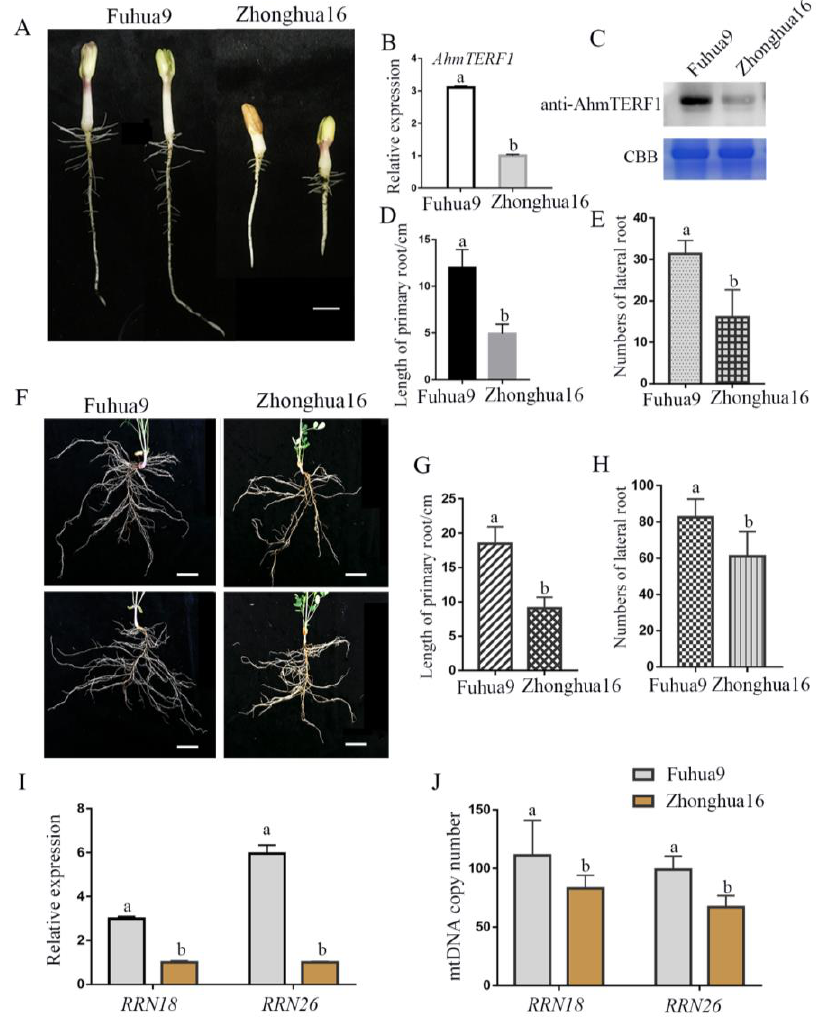
Figure 8. The effect of AhmTERF1 expression on root growth and mtDNA copy number in Fuhua9 and Zhonghua16 peanut cultivars. ( A ): Phenotype of 5 d-old Fuhua9 and Zhonghua16 cultivars. ( B , C ): AhmTERF1 transcript and protein expression, respectively, in the roots of 5 d-old Fuhua9 and Zhonghua16. ( D , E ): Length of primary root and number of lateral roots of 5 d-old Fuhua9 and Zhonghua16. ( F ): Phenotype of 25 d-old Fuhua9 and Zhonghua16 cultivars. ( G , H ): Length of primary root and number of lateral roots, respectively, of 25 d-old Fuhua9 and Zhonghua16. ( I ): RRN18 and RRN26 expression in the roots of 5 d-old Fuhua9 and Zhonghua16. ( J ): mtDNA copy number in the roots of 5 d-old Fuhua9 and Zhonghua16. mtDNA was labeled with RRN18 and RRN26. Lower case letters (a, b) indicate significantly different groups ( p < 0.05).